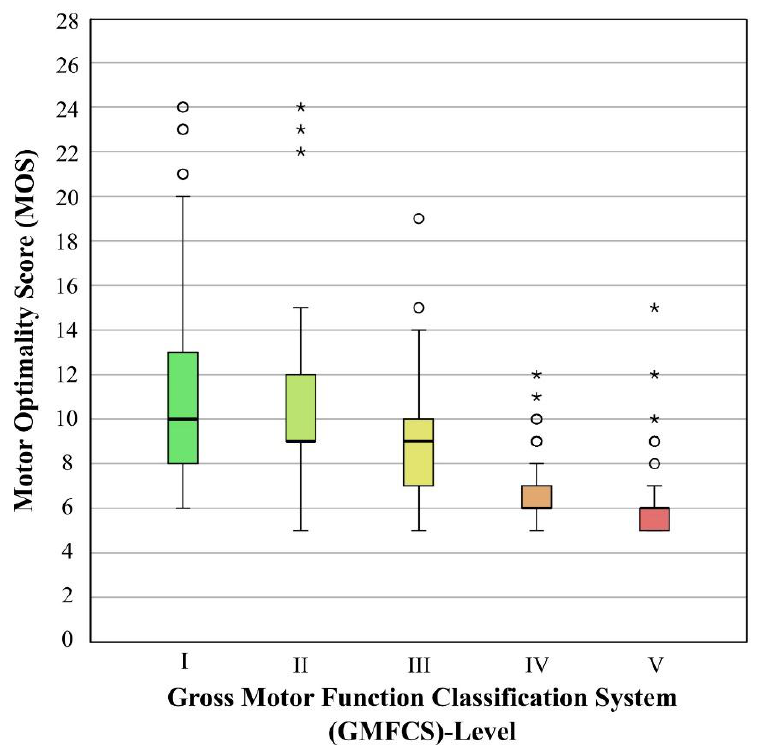
Figure 4. Distribution of the Motor Optimality Score (MOS) within the levels of the Gross Motor Function Classification System—Expanded & Revised (GMFCS-E&R). Whiskers indicate an interquartile range (IQR) × 1.5. Key: ° outliers (within 3 × IQR), * extreme outliers (>3 × IQR). The combined predictive power of the MOS-subcategories on GMFCS outcomes was estimated by means of an ordered logit model. The model fitting information suggests a significant improvement of the final model compared to the intercept-only model (Chi-square = 236.02; p < 0.001), and the test of parallel lines indicates the model to be in line with the proportional odds assumption (Chi-square = 21.81; p = 0.113). Pseudo R-square parameters (Nagelkerke = 0.416; Cox and Snell = 0.396) suggest the MOS-subcategories to explain a substantial amount of variance in GMFCS outcomes. With parameter estimates ranging between −0.19 and −1.26, increases in the scores for (i) fidgety movements, (ii) quality of movement patterns, (iv) postural patterns and (v) movement character significantly decrease the likelihood of higher GMFCS outcomes (Table 3). That is, higher scores in these predictors are associated with higher gross motor functioning. The increase in odds of changing from a lower to a higher GMFCS level for each one-unit increase in the rating of the predictors was lowest for (v) movement character (0.29), followed by (ii) quality of movement patterns (0.50), (iv) postural patterns (0.68) and (i) fidgety movements (0.83). The (iii) age-adequacy of the movement repertoire, however, may not significantly contribute to explain variation in GMFCS outcomes when the other four predictors are included in the model (Table 3). Table 3. Parameter estimates for the ordered logit model. Estimated coefficients, standard errors (SE), Wald statistics, p -values, and 95% confidence intervals (CI) for the five motor optimality score (MOS) subcategories. Subcategories of the MOS